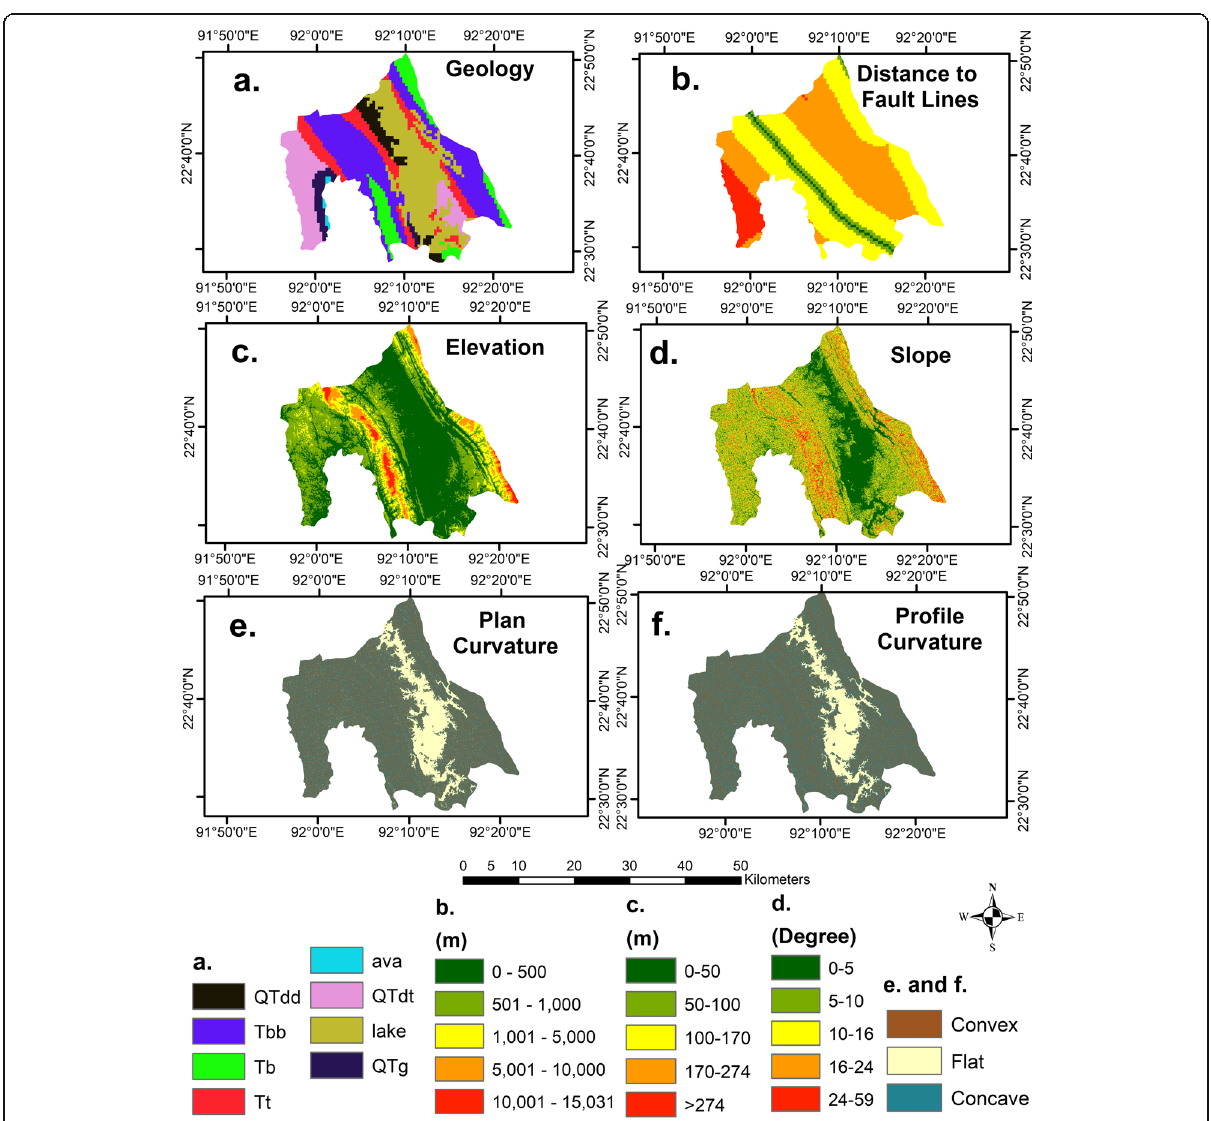
Fig. 3 Landslide Causative Factors: a . Geology; b . Distance to Fault Lines; c . Elevation; d . Slope; e . Plan Curvature; f . Profile Curvature. Qtdd = Dihing and Dupi Tila Formation; Tbb = Boka Bil Formation; Tb = Bhuban Formation; Tt = Tipam Sandstone; ava = Valley Alluvium and Colluvium; QTdt = Dupi Tila Formation; QTg = Girujan